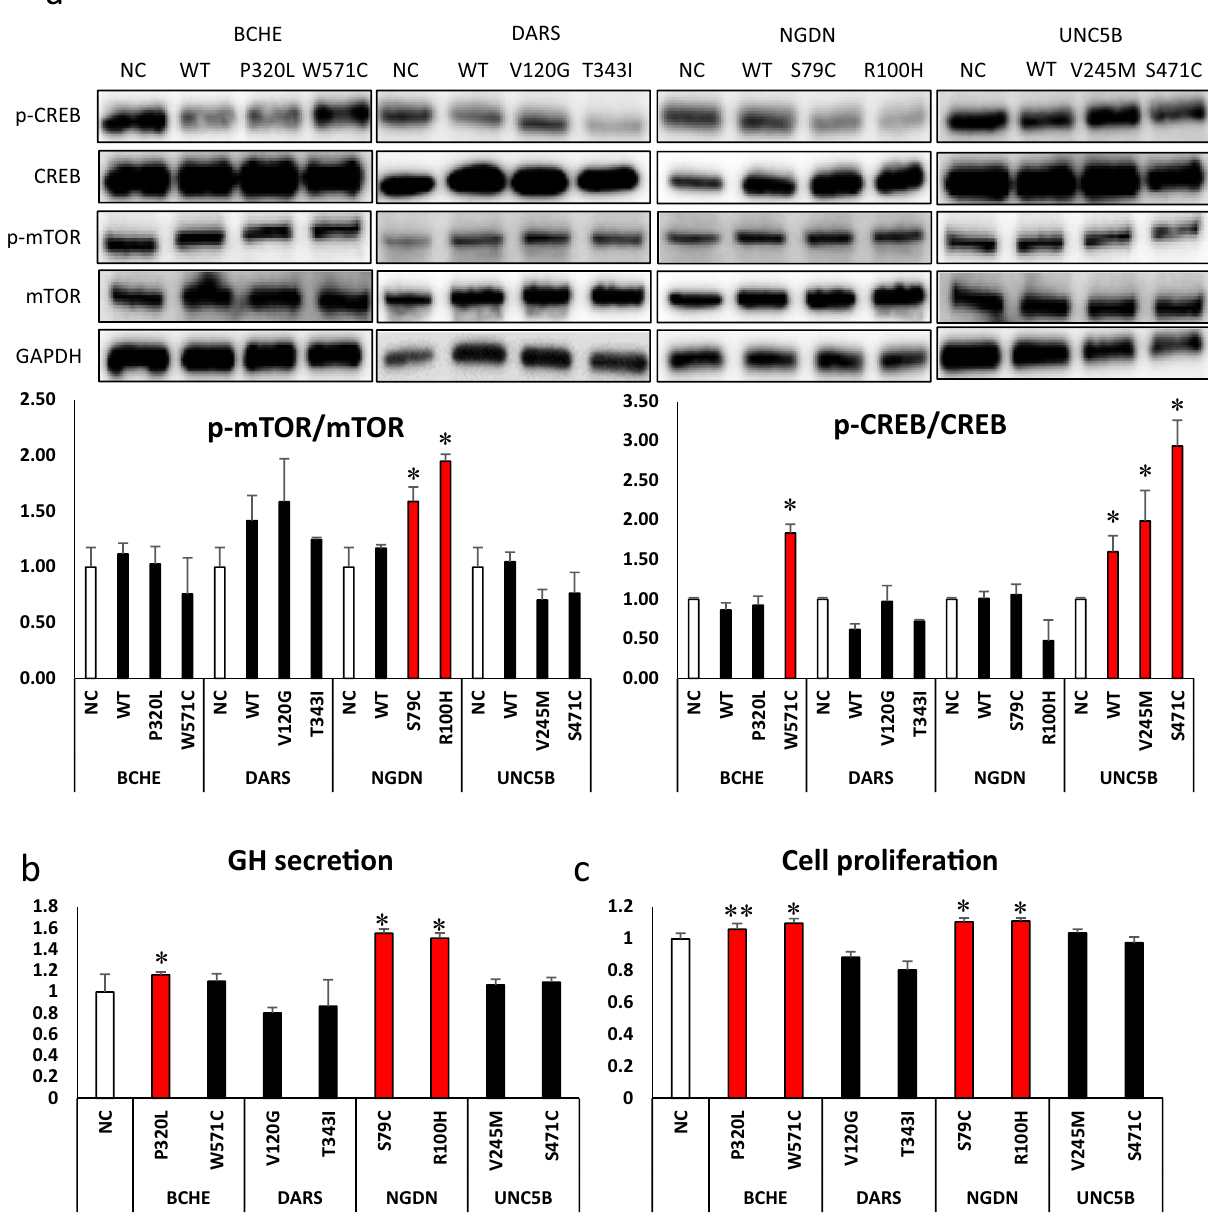
Figure 4. Biological role of somatic variants in GH3 cells. ( a ) Protein expression of genes responsible for growth hormone (GH) synthesis and secretion difference. Images of full-length blots are included in Supplementary Fig. S4 (created in Microsoft 365 Powerpoint, Excel). ( b ) GH secretion into the cell-culture media and ( c ) cell proliferation were also analyzed using transfected cells (created in Microsoft 365 Excel). All data are represented as the mean ± SE of triplicate experiments and representative of three independent experiments. Significant differences are denoted as * p < 0.05, ** p <